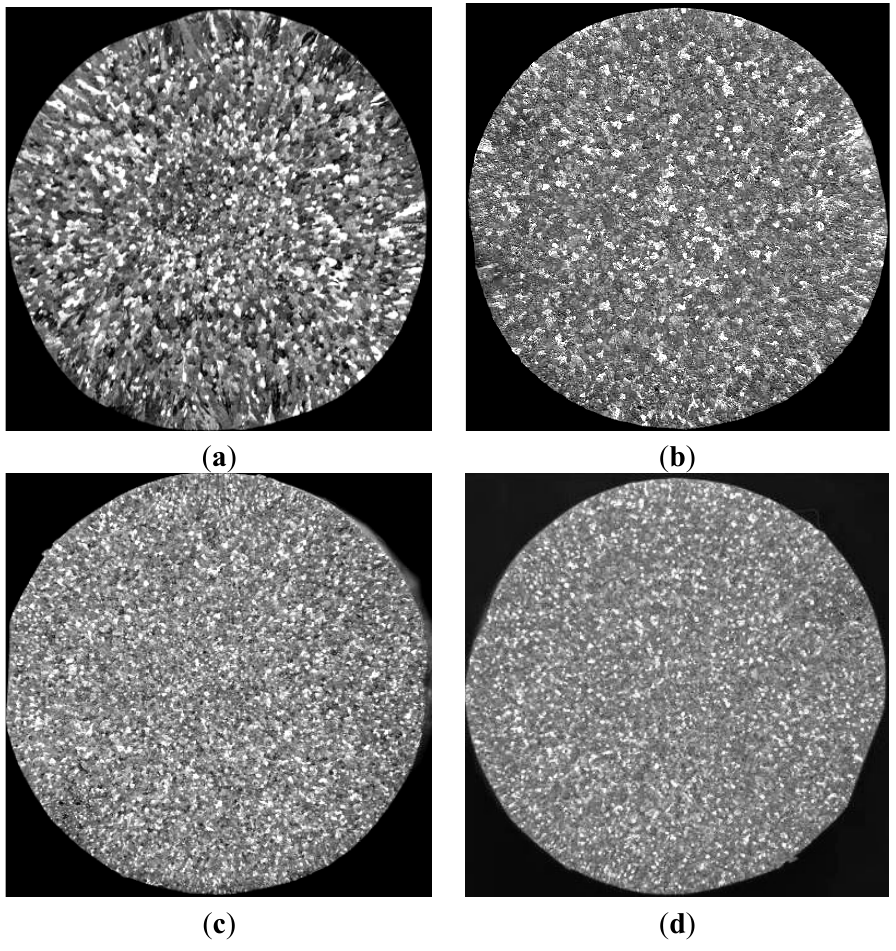
Figure 9. Effects of different additions of Al–5Ti master alloy 3 # on grain size of solidified commercial pure aluminum sample (holding for 5 min): ( a ) 1.0%; ( b ) 1.6%; ( c ) 2.0%; ( d )